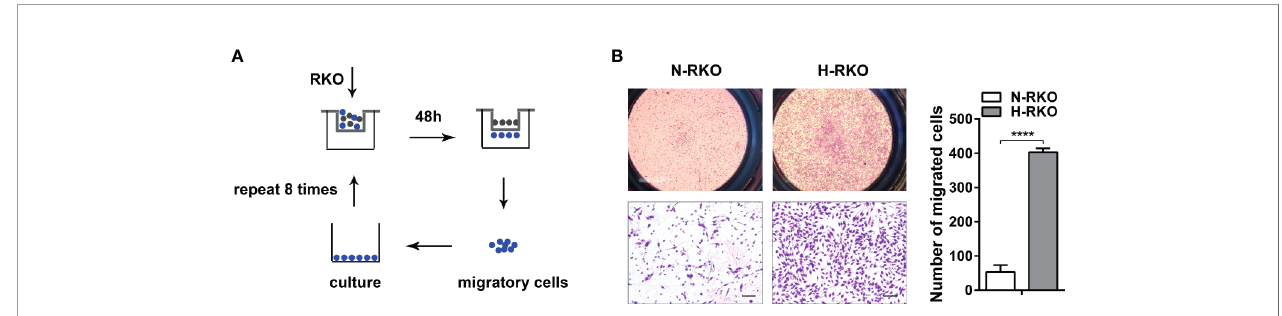
FIGURE 1 | Generation of a highly migratory CRC cell subline from the RKO cell line. (A) Procedure summary schematic for establishing a CRC cell subline with a high migratory potential from parental RKO cells (N-RKO) using a repeated transwell assay. H-RKO: the highly migratory RKO; N-RKO: the parental RKO. (B) Transwell assay showed that H-RKO had a higher migration rate compared to the parental N-RKO cells. Top: 40 ×; bottom: 200 ×. Scale bars: 50 m m. **** p <